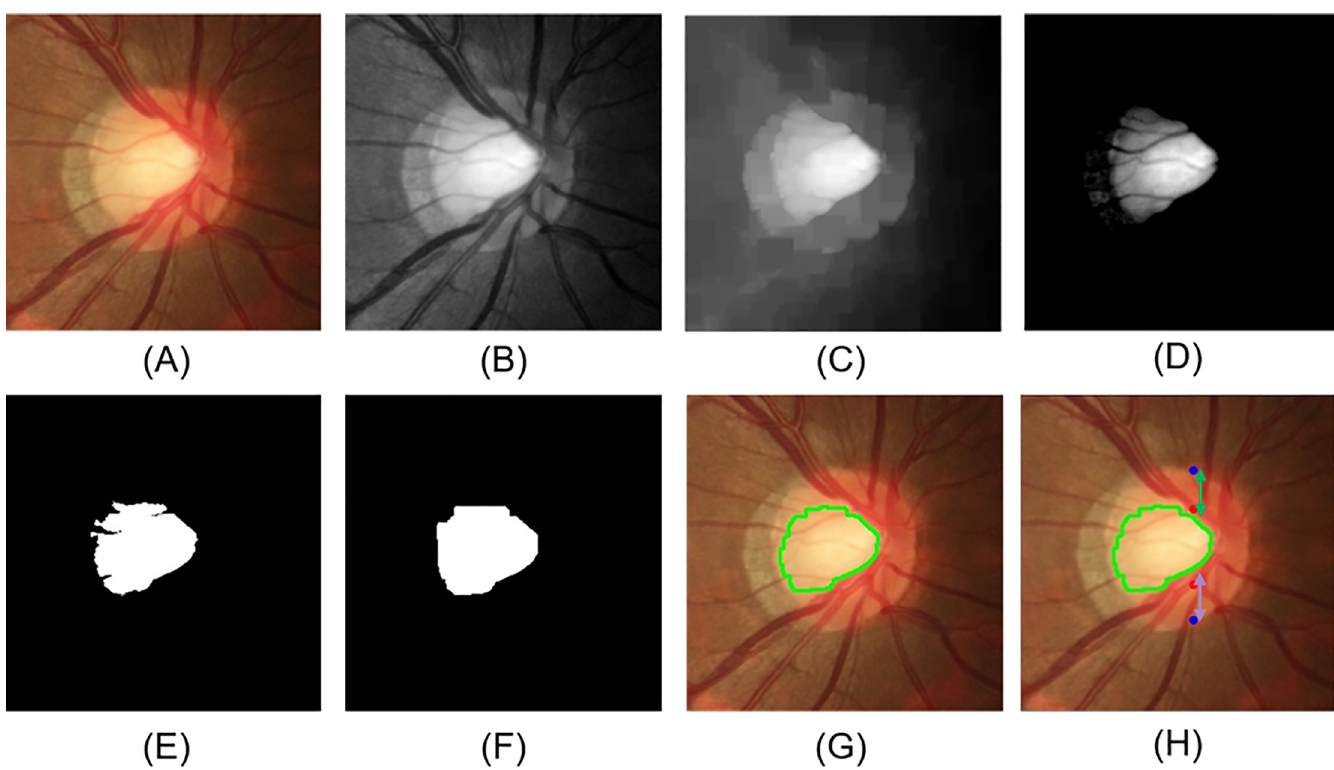
Fig 5. Process to determine the disc margin, cup area, vertical cup-to-disc ratio, and superior and inferior neuroretinal rim-to-disc ratio. (A) Color fundus image after ROI extraction; (B) green and red channel processing; (C) removal of the vessels; (D) processing by subtracting the mean and standard deviation; (E) K-means clustering; (F) morphological operations to remove noise; (G) the cup boundary (green line); (H) vertical disc diameter (between blue points), cup diameter (between red points), superior rim (green arrow), and inferior rim (purple arrow). ROI, region of